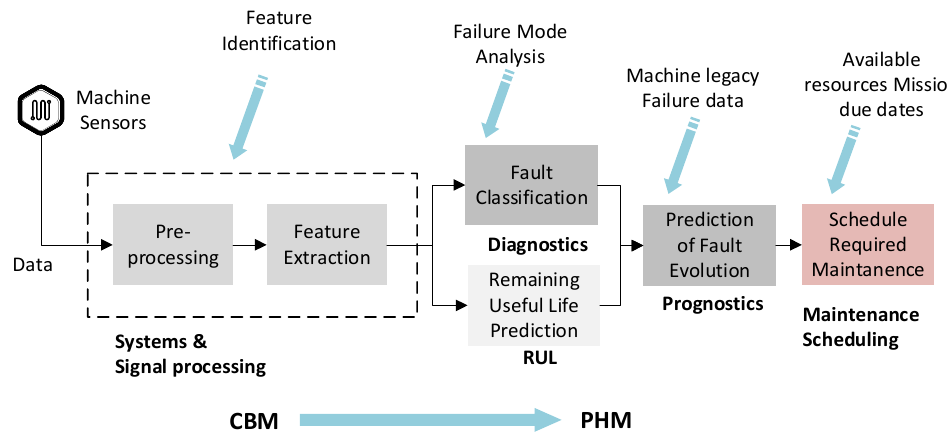
Figure 1. The condition-based maintenance/prognostics and health management (CBM/PHM) cycle.